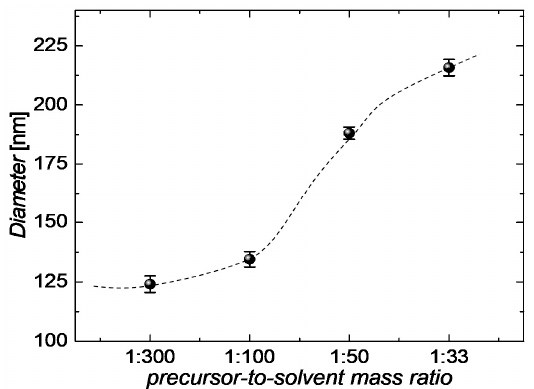
Figure 3. Mean diameters extracted using DiameterJ from the FESEM-images illustrated in Figure A1 for the precursor-to-solvent series with different mass ratios. The dashed line serves as a guide to the eye.